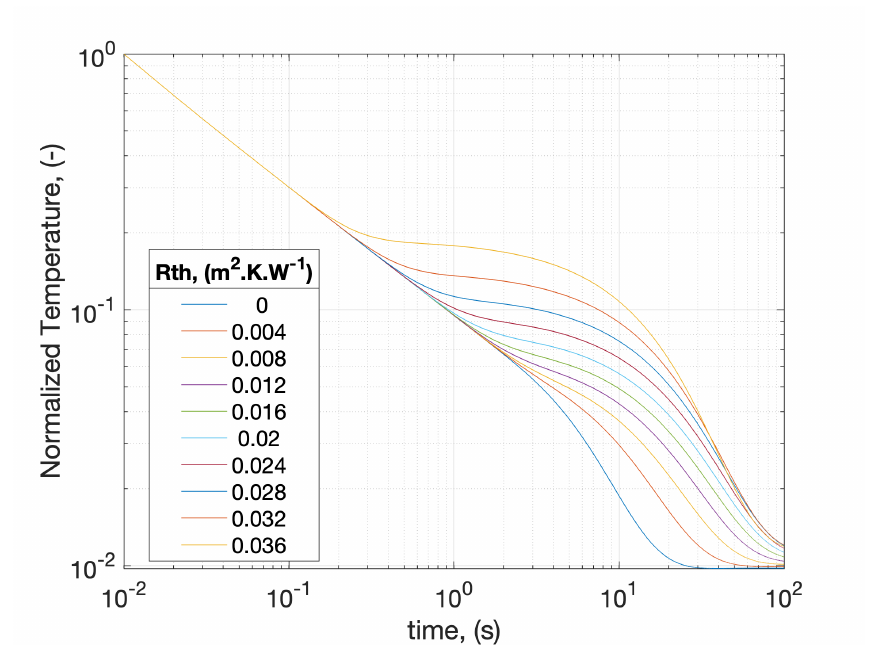
Figure 4. Loglog dimensionless temperature response of the front face to a pulse of 1 ms duration and under adiabatic boundary conditions as a function of the thermal resistance depth and thickness of the reference sample composed of polycarbonate and